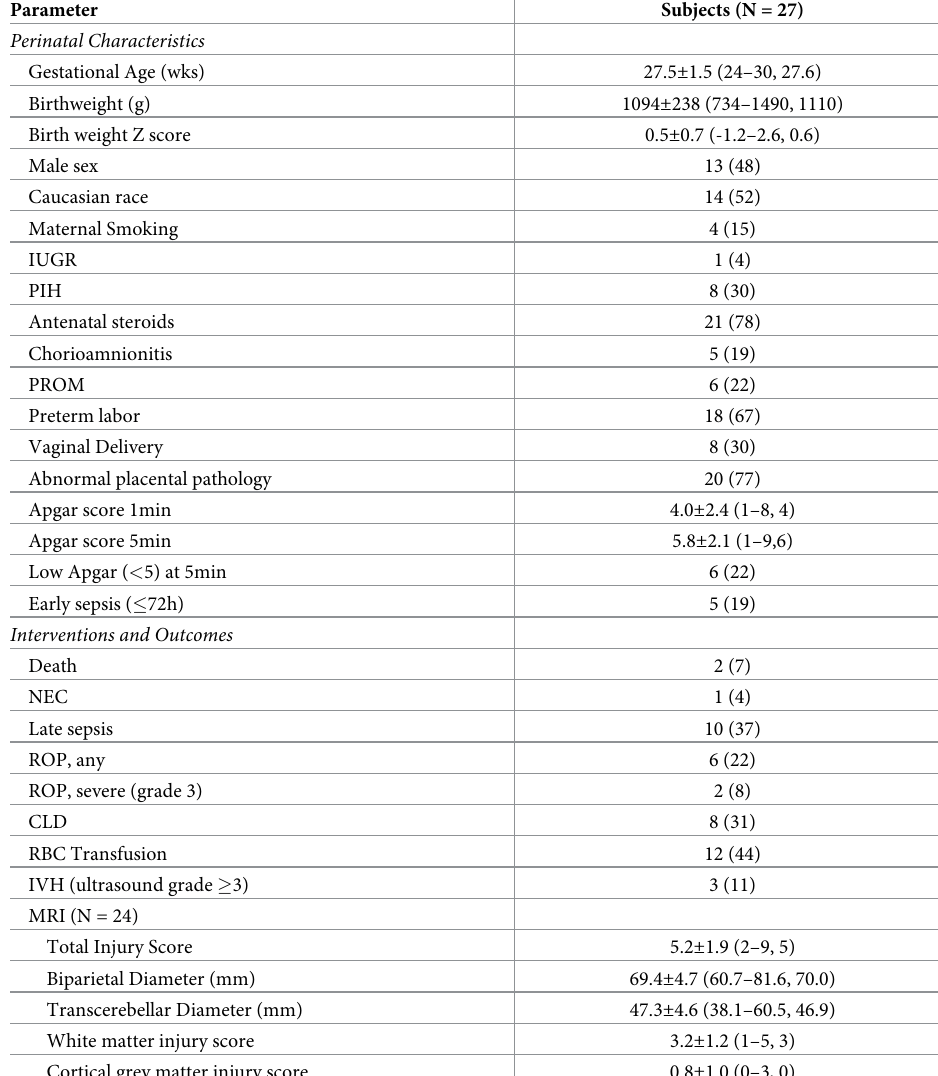
White matter injury score 3.2 ± 1.2 (1–5, 3) Cortical grey matter injury score 0.8 ± 1.0 (0–3, 0) Binary variables presented as n (%), continuous variables as mean ± SD (range, median). Abbreviations: IUGR, intrauterine growth retardation; PIH, pregnancy induced hypertension (preeclampsia); PROM, premature rupture of membranes; NEC, necrotizing enterocolitis; ROP, retinopathy of prematurity; CLD, chronic lung disease; RBC, red blood cell; IVH, intraventricular hemorrhage; MRI, magnetic resonance imaging. MRI near term-equivalent post- menstrual age was available for 24 (90%) of